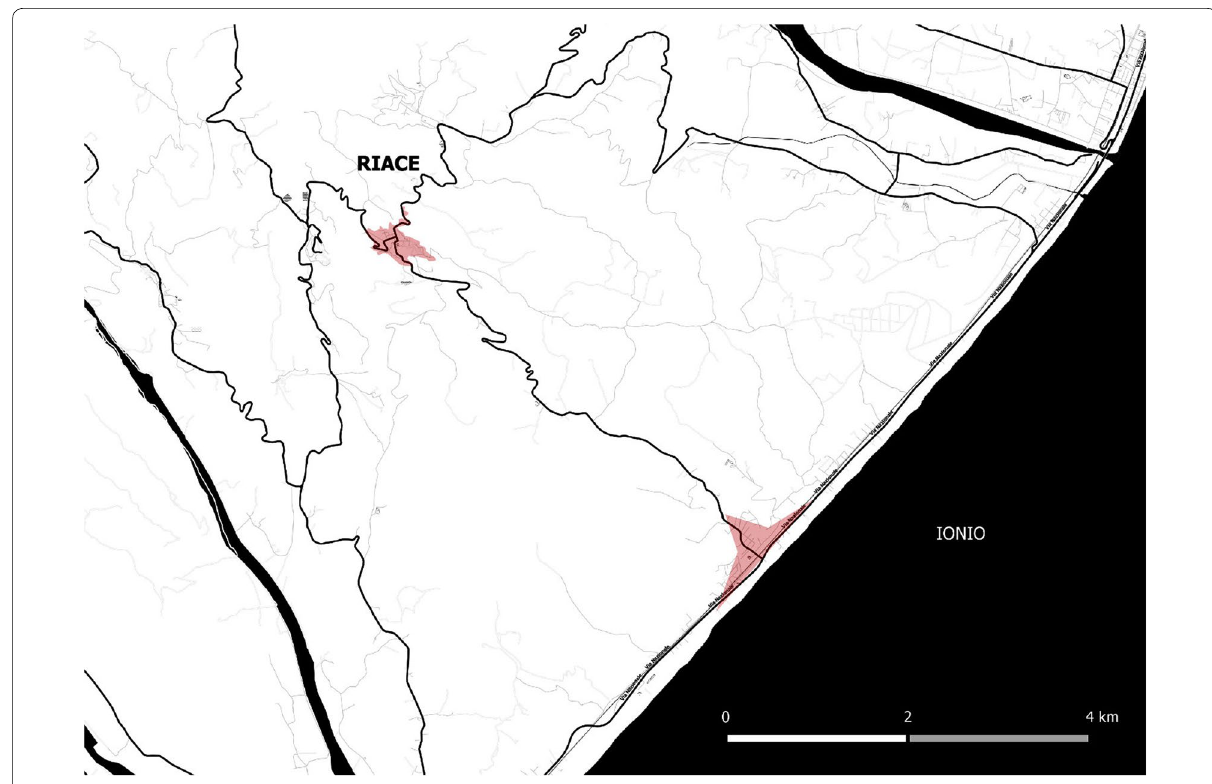
Fig. 2 Location of Borgo Superiore and